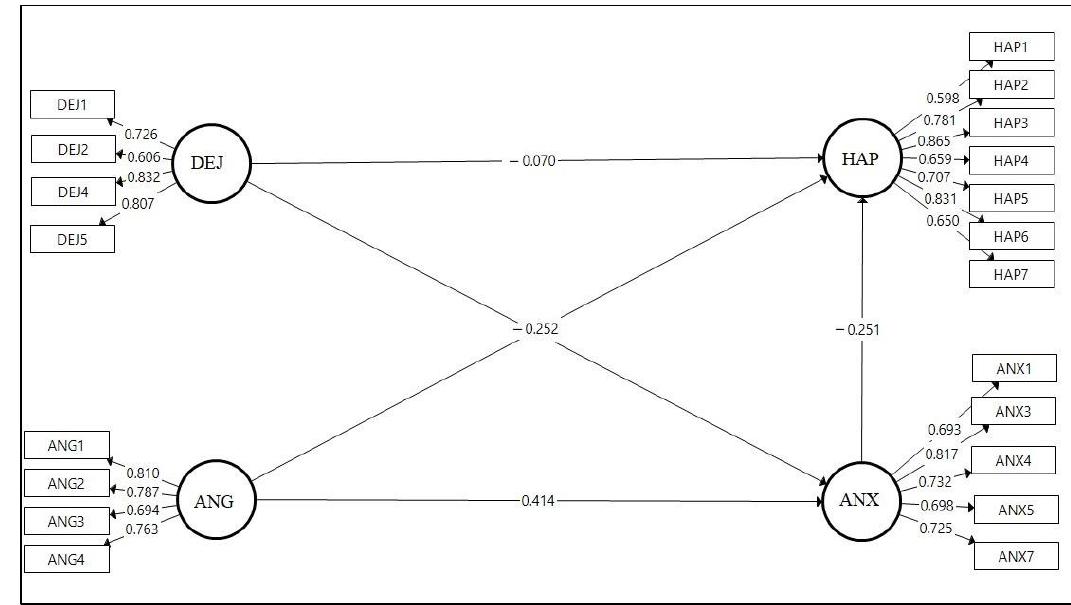
Figure 3. A final structural model with outer loading.